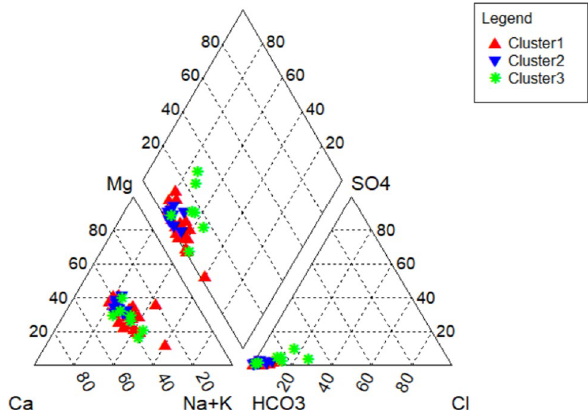
Fig. 8 The trilinear Piper plot showing the major